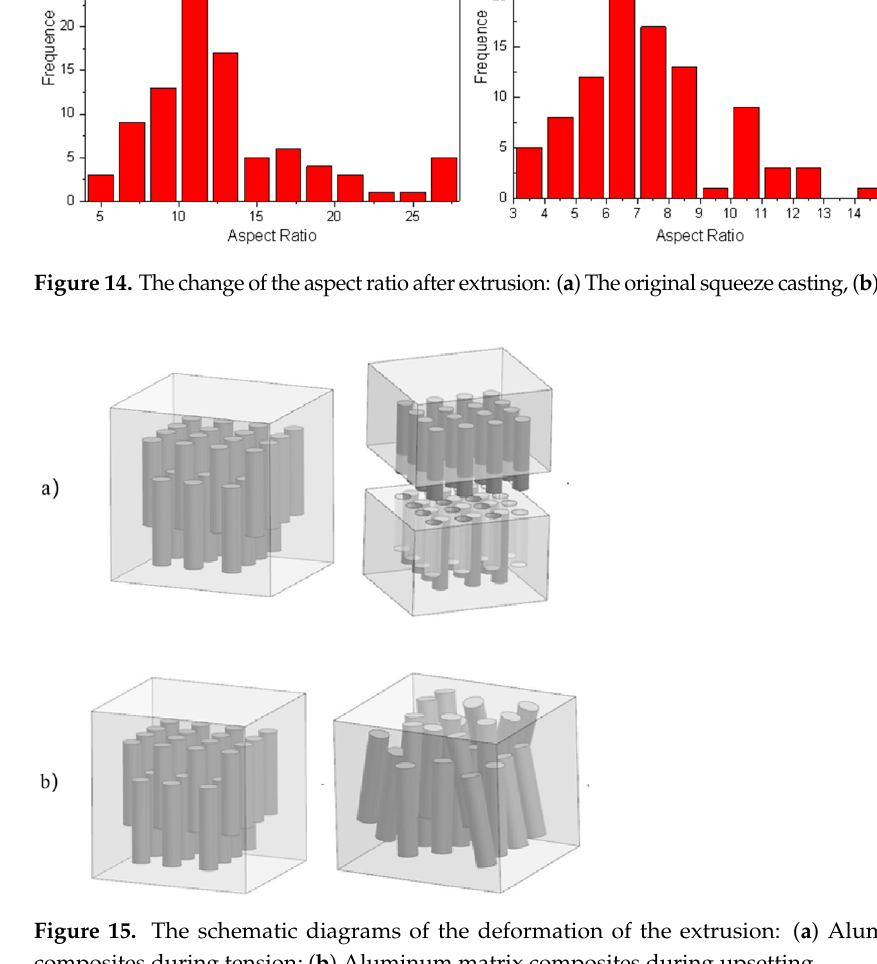
Figure 15. The schematic diagrams of the deformation of the extrusion: ( a ) Aluminum matrix composites during tension; ( b ) Aluminum matrix composites during upsetting.